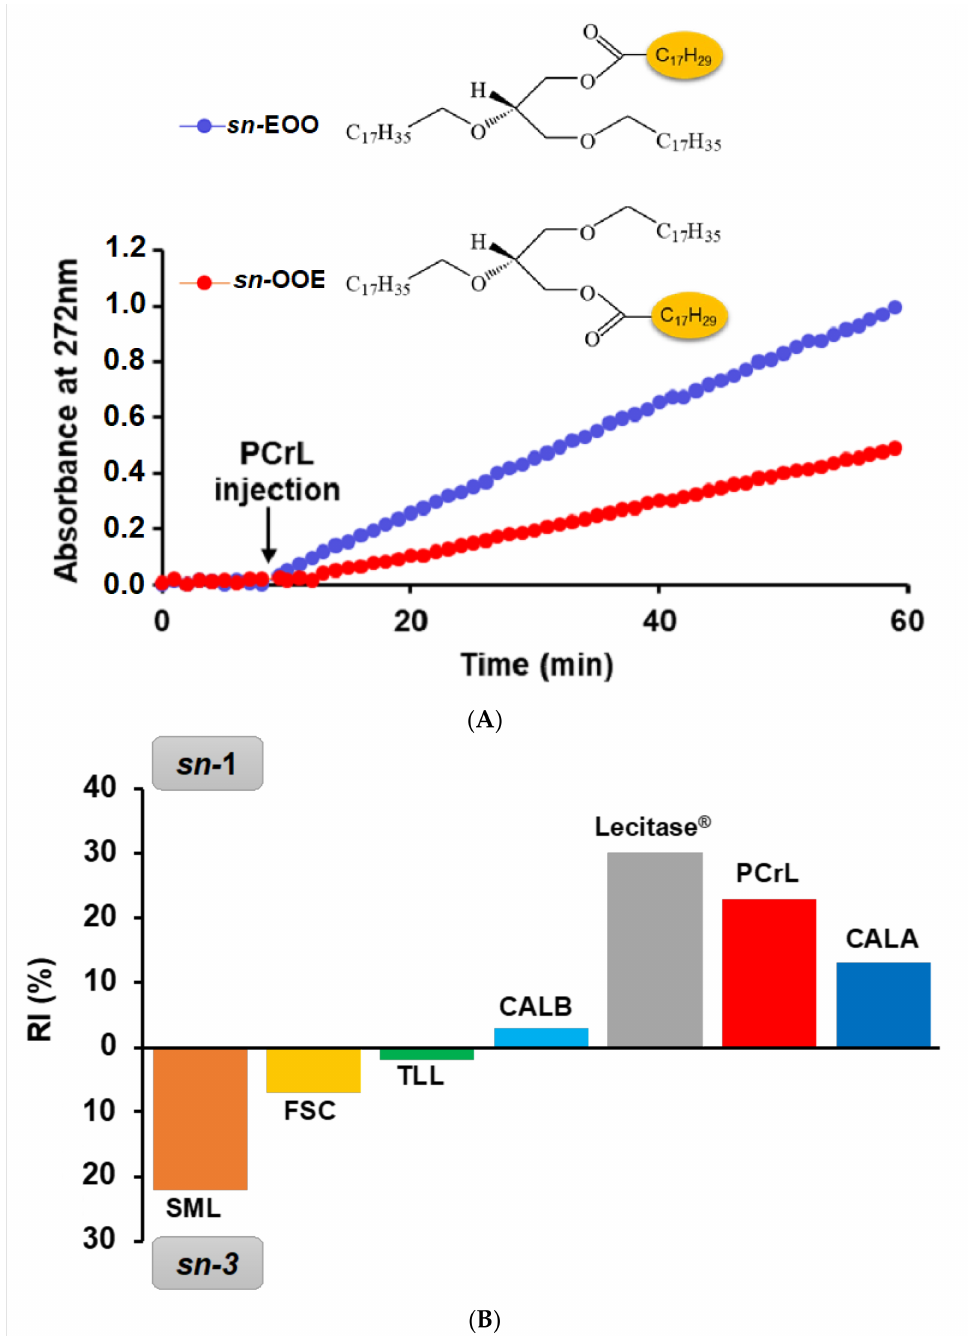
Figure 7. Regioselectivity of PCrL toward synthetic TGs. ( A ) Kinetics of surface-coated sn -EOO or sn -OOE hydrolysis by PCrL. The variation in absorbance at 272 nm was recorded for 10 min to obtain the baseline, then for 50 min after the injection of PCrL (0.65 µ g per well). The kinetic recordings shown here are typical of those obtained in three independent experiments. ( B ) RI% of PCrL using surface-coated sn -EOO or sn -OOE compared with those of SML, FSC, TLL, Lecitase, CALA, and CALB reported in our previous studies